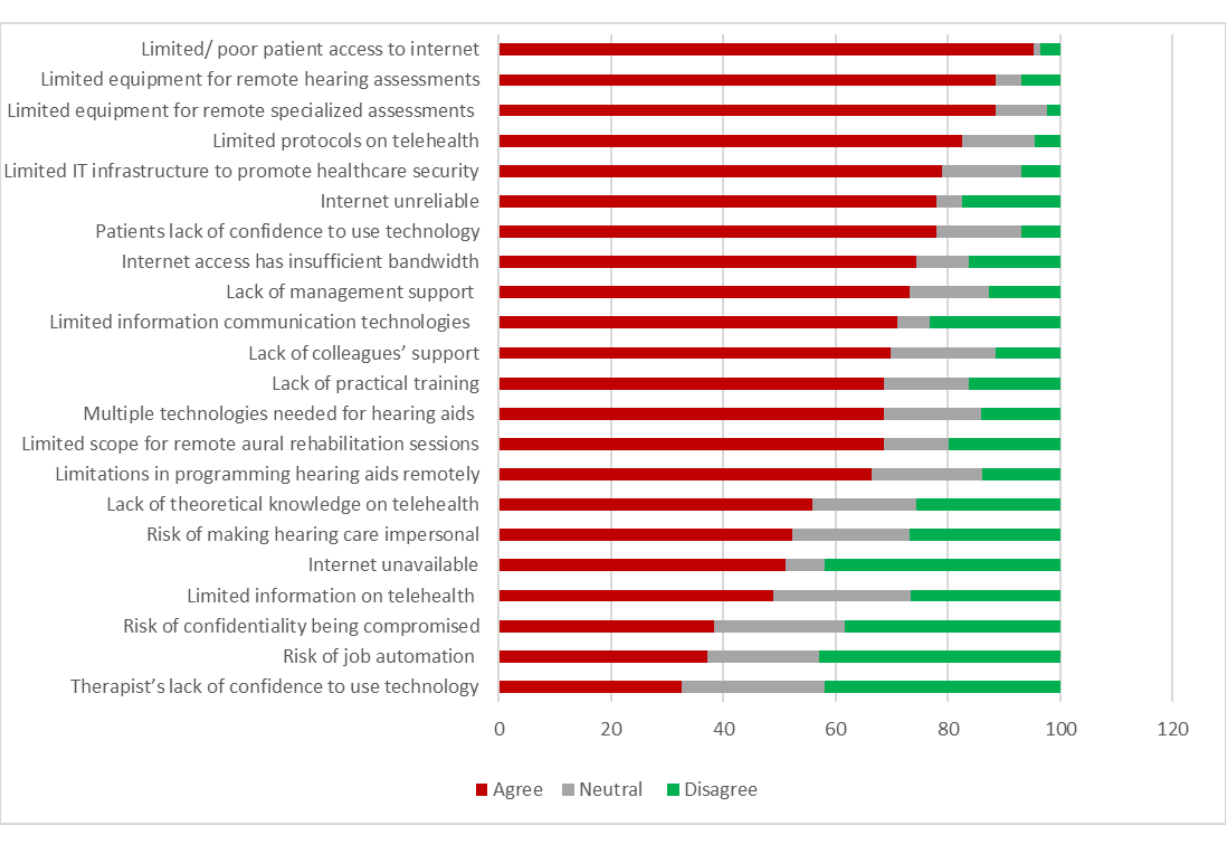
Figure 3. Perceived barriers toward telehealth service delivery within South African public sector hospitals, indicated in terms of % ( n = 86).